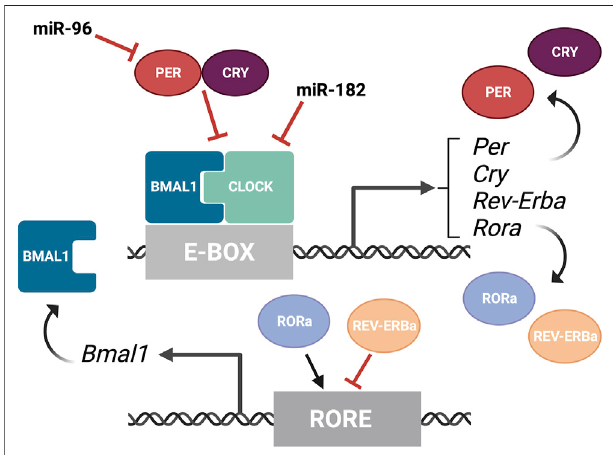
FIGURE 3 | Overview of the molecular components of the circadian rhythm. Circadian rhythm isregulated by two interwoven feedback loops. The fi rst loop involves CLOCK and BMAL1 activating regulatory elements containing E-boxes to induce expression of repressors. PER and CRY proteins bind to CLOCK/BMAL1 to repress the transcriptional activity of their activators. MiR-182 targets CLOCK, among other circadian rhythm regulators, and miR-9 targets PER-2. The second loop involves REV-ERB α andROR α competingforbindingonROREbindingelements,whichpromotes Bmal1 transcription. This fi gure was created with